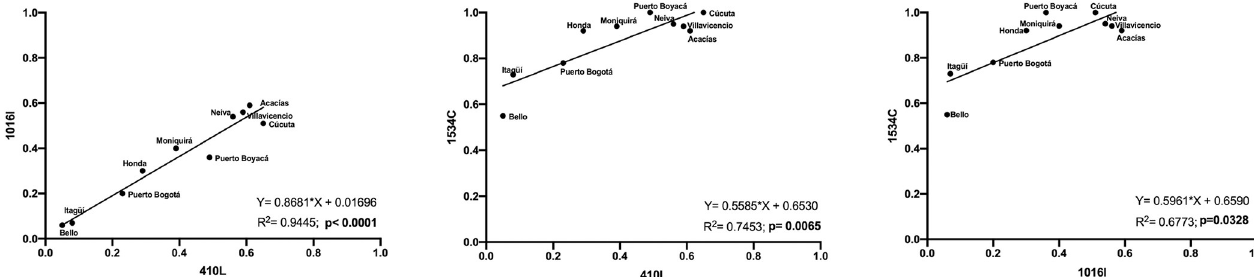
Fig 6. Linear regressions of the sodium channel mutation frequencies at positions 410L vs. 1016I, 410L vs. 1534C, and 1016I vs. 1534C. The data for 410L and 1016I passed normality tests, while the other comparisons did not pass (D’Agostino & Pearson and Shapiro-Wilk tests; alpha = 0.05).